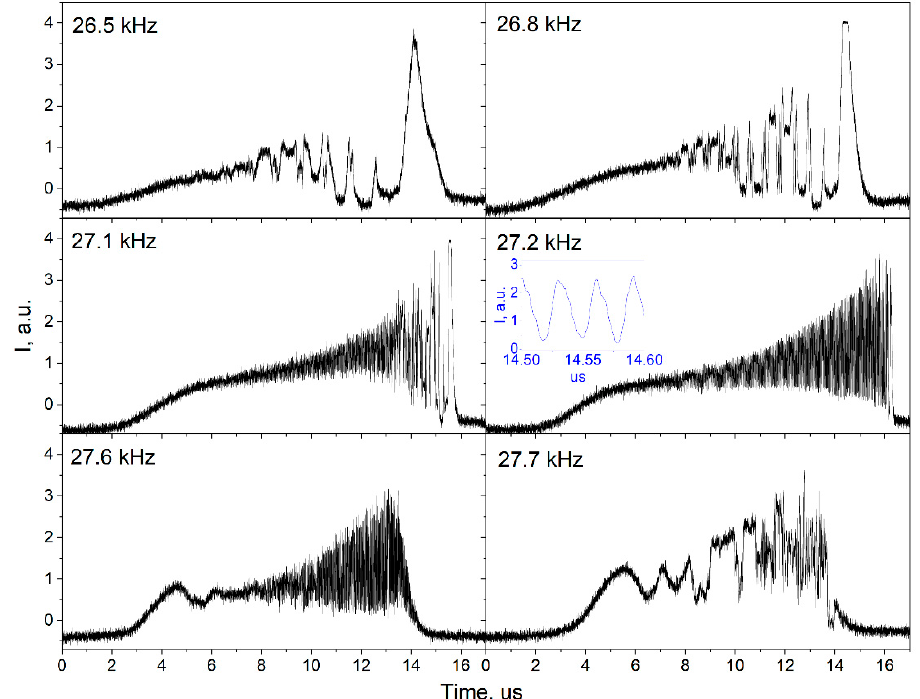
Figure 9. Output pulses at different repetition rates of the LD current modulation. Inset: zoomed sub-pulses.